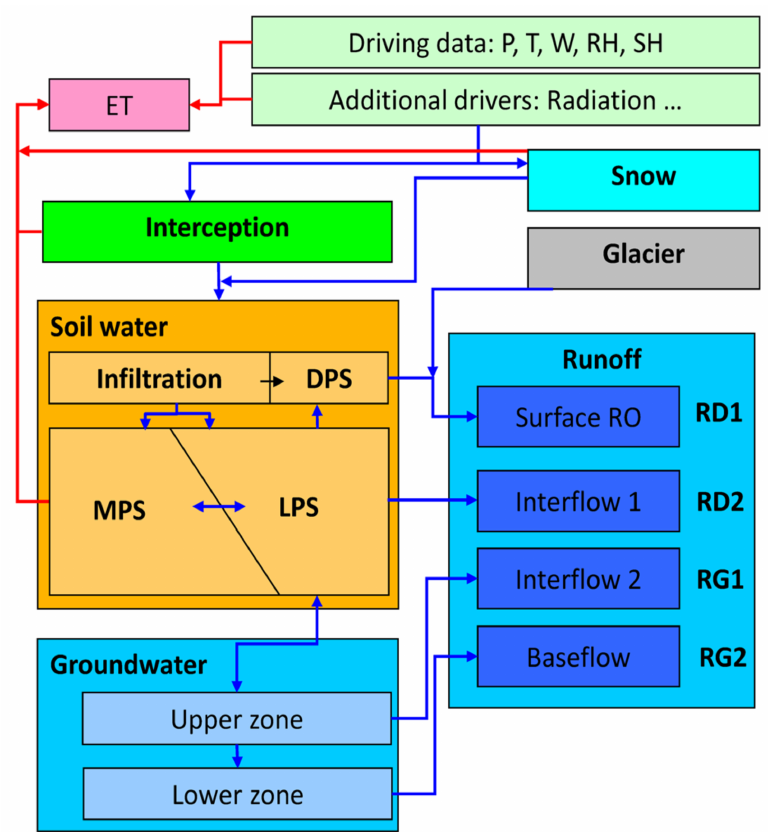
Figure 3. Structure of J2000 hydrological model (P: precipitation; T: temperature; W: wind speed; RH: relative humidity; SH: sunshine hour; LPS: large pore storage; MPS: middle pore storage; DPS: depression storage; RO: runoff)